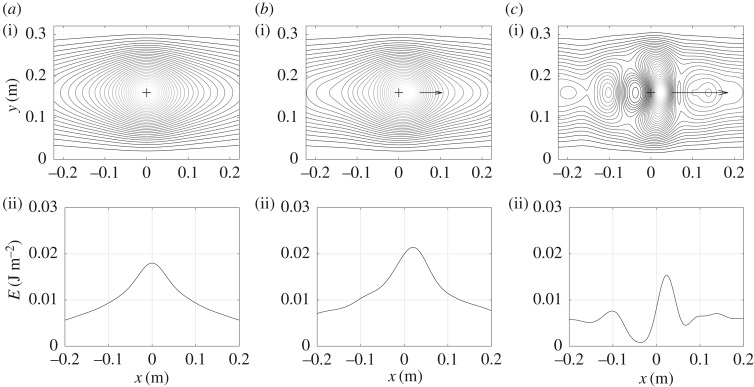
Repartition of Lagrangian vibrational energy E∂ near the moving point force at f = 200 Hz for various moving speeds. Isovalues of energy (i) and energy versus position along the horizontal line y = 0.16 (ii): (a) V = 0 km h−1, (b) V = 90 km h−1 and (c) V = 216 km h−1.